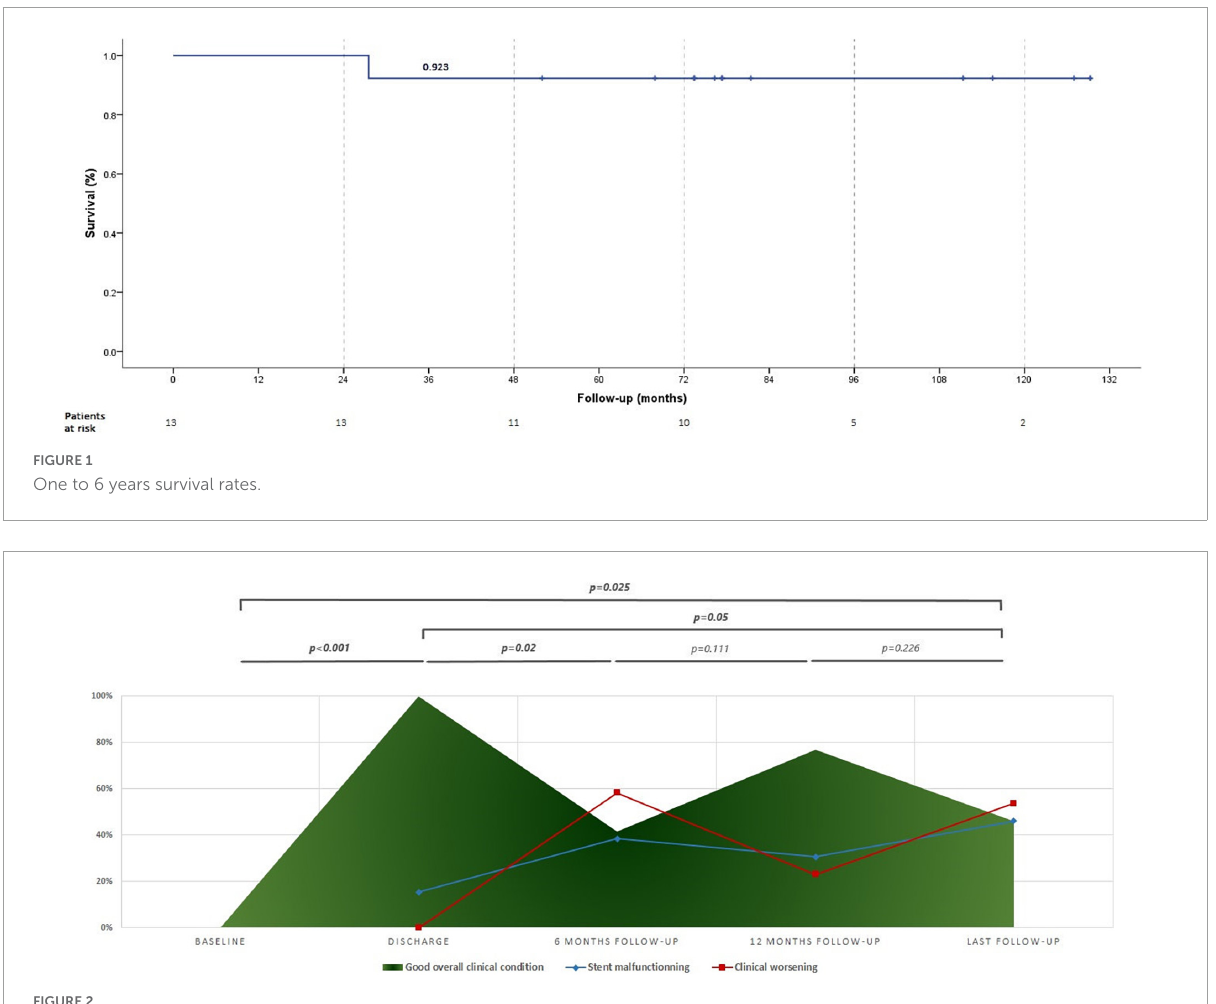
FIGURE2 Progression of overall clinical status across follow-up. The clinical worsening is defined by the presence of at least one of the following: (1) worsening in world health organization- Functional class (WHO-FC); (2) NT-pro BNP ≥ 1,400 pg/ml; (3) tricuspid annular plane systolic excursion (TAPSE) ≤ 15 mm; (4) increase or adjunction of diuretics; and (5) adjunction of new pulmonary arterial hypertension (PAH) specific medical therapy. Stent malfunctioning is defined as maximum velocity on stent > 2